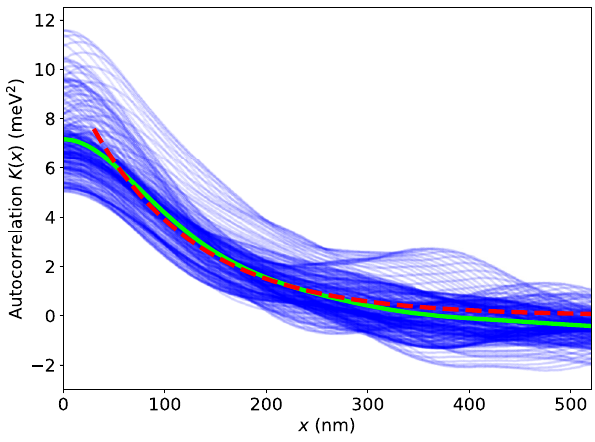
FIG. 9. Autocorrelation function K ( x 0 , x 0 + x ) of the matrix element δ M gg ( x 0 ) = (cid:11) g o | δ V ( x ) | g o (cid:7) , defined in Eq. (9), calcu- lated for device geometry and voltages used in Figs. 7(d) and 7(f), and averaged over 80 disorder realizations. Blue lines correspond to 250 distinct values of x 0 . We plot averaged auto- correlation (solid green line) and an exponential fit (dashed red gg line) for x > L dot of the K gg ( L dot ) e −| x − L dot | / l c form. The fitted (cid:11) values K gg ( 0 ) = 2.8 meV and l gg c = 90 nm indicate typical amplitude and correlation length of effective 1D disorder δ V ( x ) . (cid:12) L The long correlation length l δ V dot is an indicator of stability c of the moving QD against potential